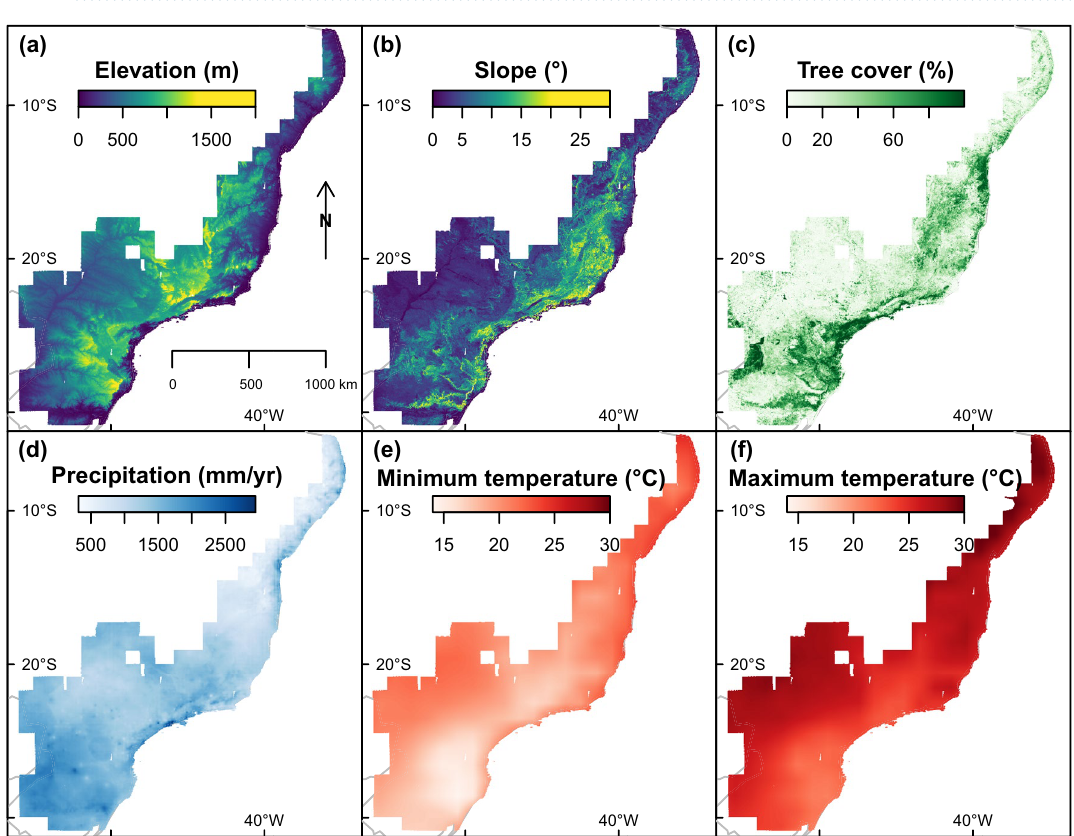
Figure 12. Environmental and climatic variables used in the study to analyse spatial distribution of Pleroma trees ( a ) elevation (m), ( b ) slope (°), ( c ) tree cover (%), ( d ) mean annual precipitation (mm yr −1 ), ( e ) annual mean of minimum temperatures (°C), and ( f ) maximal annual temperatures